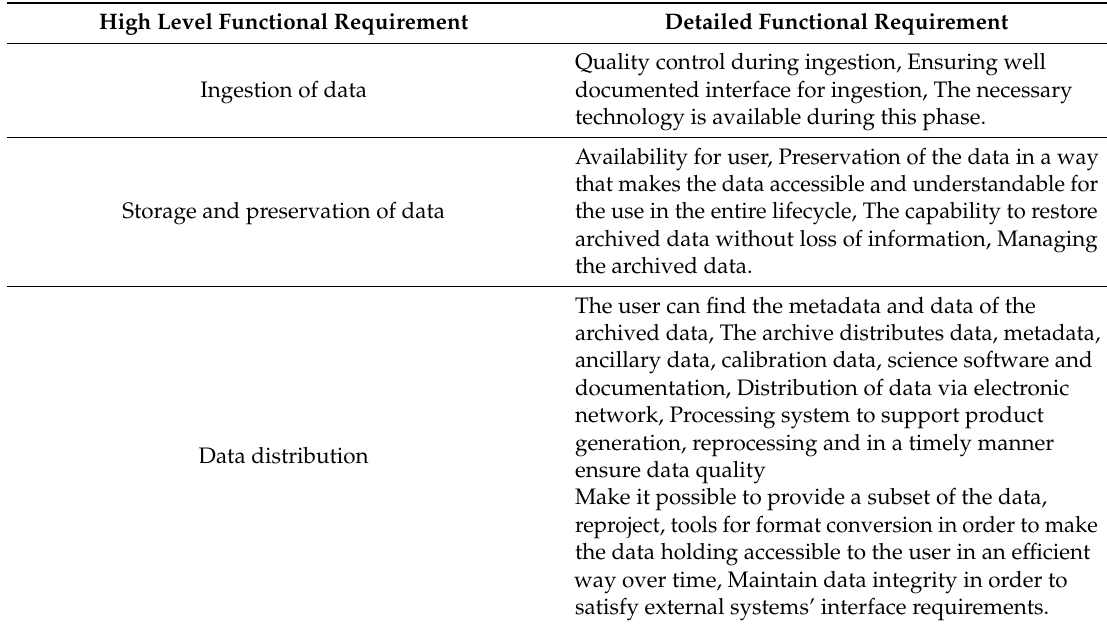
Table 9. Functional requirements for preservation of geospatial data and